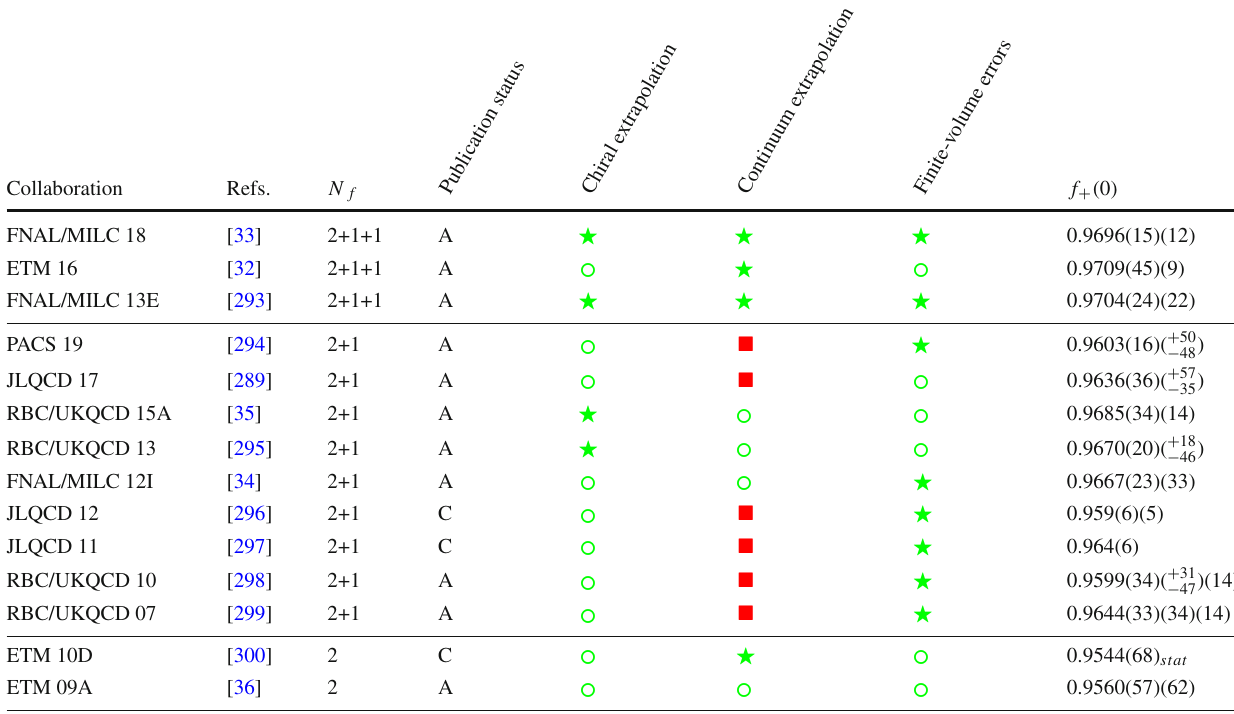
Table 15 Colour code for the data on f + ( 0 ) . In this and previous editions [4], old results with two red tags have been dropped